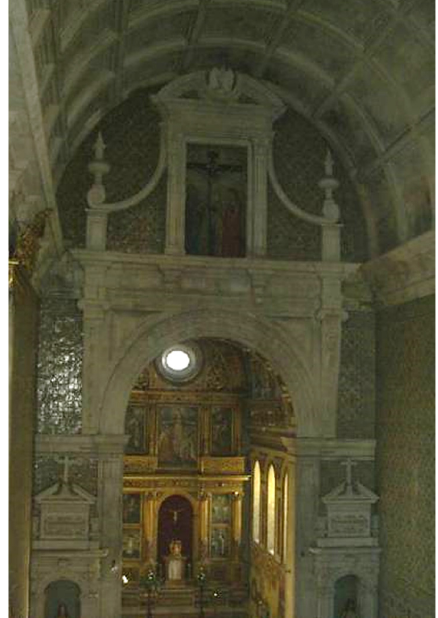
Figure 3. Inside the church: cross arch. The front of the church, 14 m wide, develops through rectilinear lines marked by the wedges that finish as Tuscan pilasters, on which rests the general threshold, growing up the triangular pediment, bordered laterally by small pyramids with a pedestal in the ex- tension of the wedges as in the line of the eaves. In the center, the finish is achieved by a high cross of stone, also with a pedestal, in the closure of the gable. The austere character of the church’s frontage is aggravated by the application of stamped blue and white ce- ramic tiles, dated from 1867 [36]. The building was surveyed for data acquisition by utilizing different sources, namely direct observation, fieldwork, archival data and a Terrestrial Laser Scanner (TLS), to ob- tain a 3D point cloud. Regarding the survey campaign developed with the TLS, the in- strument used was the Leica BLK360. This equipment is a stationary laser scanner of the Continuous Wave–Frequency Modulation (CW-FM) type. The system can measure with great precision the direction of pointing, in addition to a distance meter that emits contin- uous light radiation. A survey design should first define the TLS station locations to en- sure complete coverage of the object at the required spatial resolution and to avoid areas of occlusion. Considering the architectonical features in the interior space of the church, the instrument was set to have a resolution of 6 mm in 10 m. The 3D point cloud model was obtained by means of 12 scans. With a total of 12 internal scans and 5 external scans (belonging only to the façade), the TLS acquisition campaign took almost 3 h, with a sin- gle-scan time of approximately 6 min. The 3D building model was produced by means of the 3D point cloud obtained. The scanner processing was performed in Cyclone Register 360 software from Leica, which processes the scans to eliminate the reconstruction of a 3D geometric model of the struc- ture based on georeferenced images and laser scanner algorithms. The data processing was performed with Cyclone Register 360 utilizing the Iterative Closest Point algorithm: given the set of scans, the ICP algorithm searches for all the possible connections between the pairs of point clouds with overlap. For each connection, a pairwise ICP is performed and the best matching point pairs between the two scans are saved. A final non-linear minimization is run only among these matching point pairs of all the connections. The global registration error of these point pairs is minimized, having as unknown variables the scan poses [37].